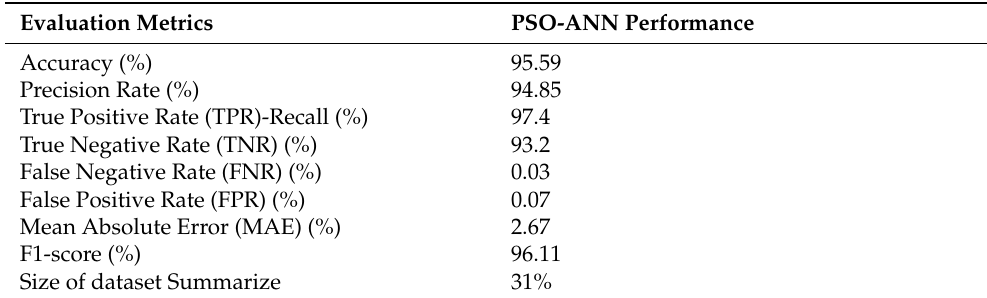
Table 2. The classification performance of the ANN without dataset summarization on MNIST dataset.